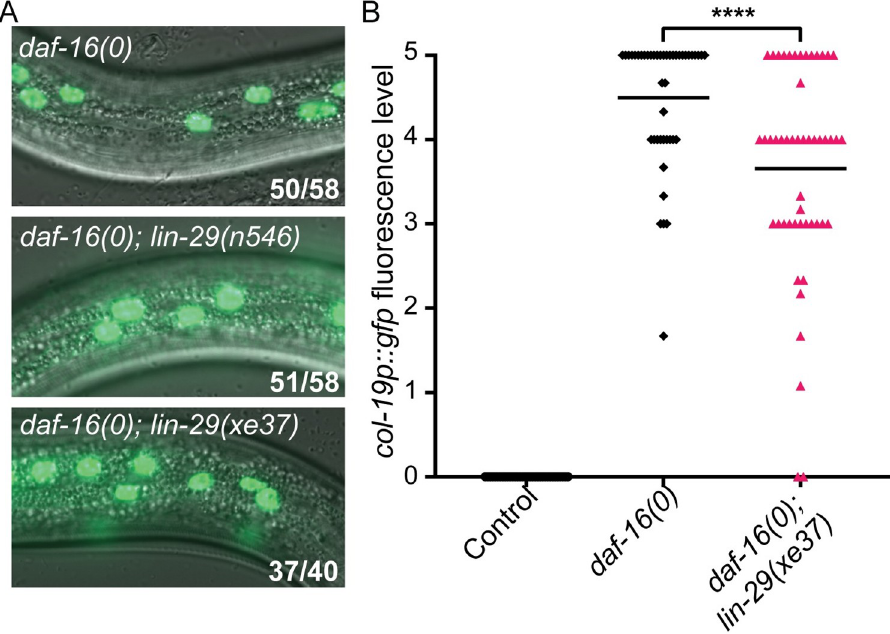
Fig 5. daf-16 acts at least partially independently of lin-29 to block adult cell fate during dauer. (A) daf-16(0); lin- 29(0) dauers expressed col-19p :: gfp at a similar penetrance to daf-16(0) dauers. n546 is a nonsense mutation and xe37 is a deletion of all but 27 amino acids. Images were taken with a 63x objective. Numbers indicate the number of dauers expressing hypodermal col-19p :: gfp over the total number of dauers. (B) Levels of col-19p :: gfp are slightly reduced in daf-16(0); lin-29(xe37) dauer larvae compared to daf-16(0) dauers. Fluorescence levels were determined as described in S7 Fig. ���� p < 0.0001 (Two-tailed Mann-Whitney Test). n = 34–50; see S8 Table for complete underlying numerical